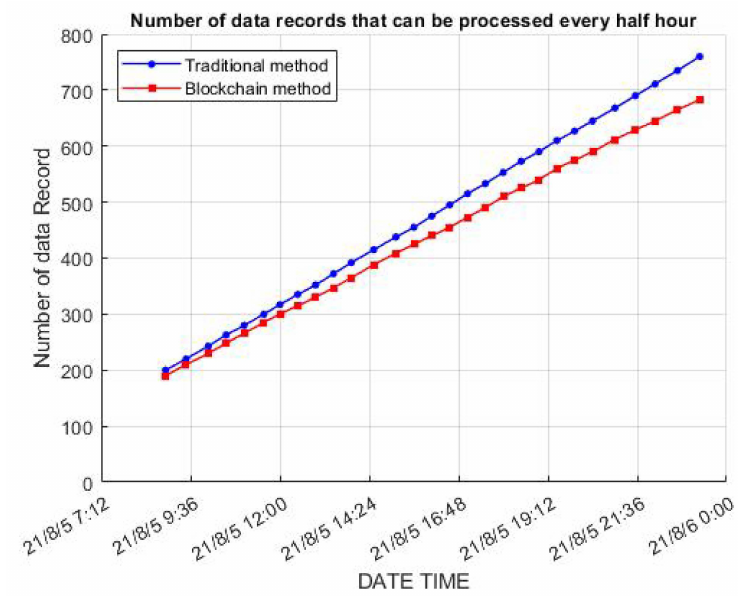
Figure 12. Traditional and blockchain-based methods are